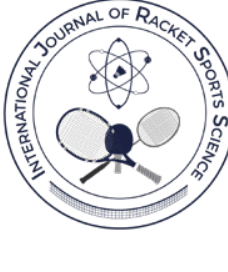
Predicting Table Tennis Tournaments: A comparison of statistical modelling